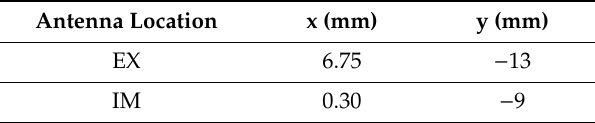
Table 1. Shorting pin location for 905 MHz resonance.